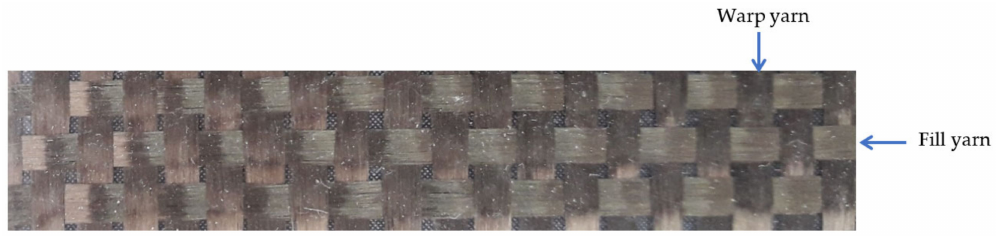
Figure 1. Bi-directional long basalt fiber fabric.